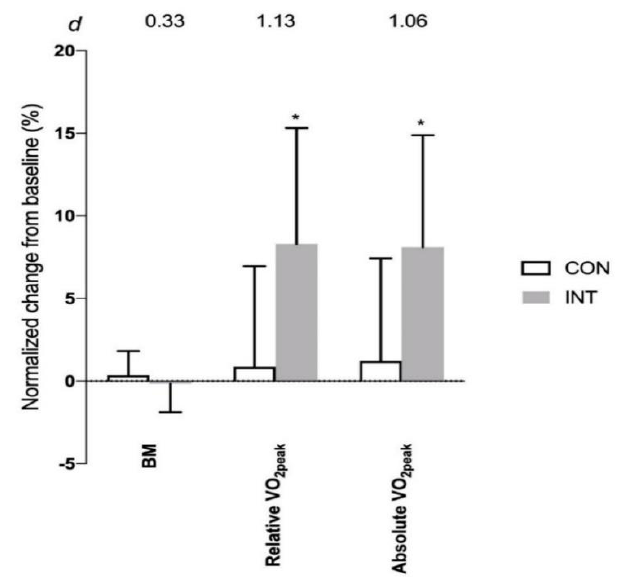
Figure 3. Normalized changes (mean ± SD) in body mass (BM) and VO 2peak from baseline (0%) to post-6 weeks training for non-training or control (CON , N = 17) group and intervention training (INT; N = 16) group. * Significance ( p < 0.01) difference from CON group. Effect size ( d ) for the difference between CON and INT groups is shown on the top of the graph.